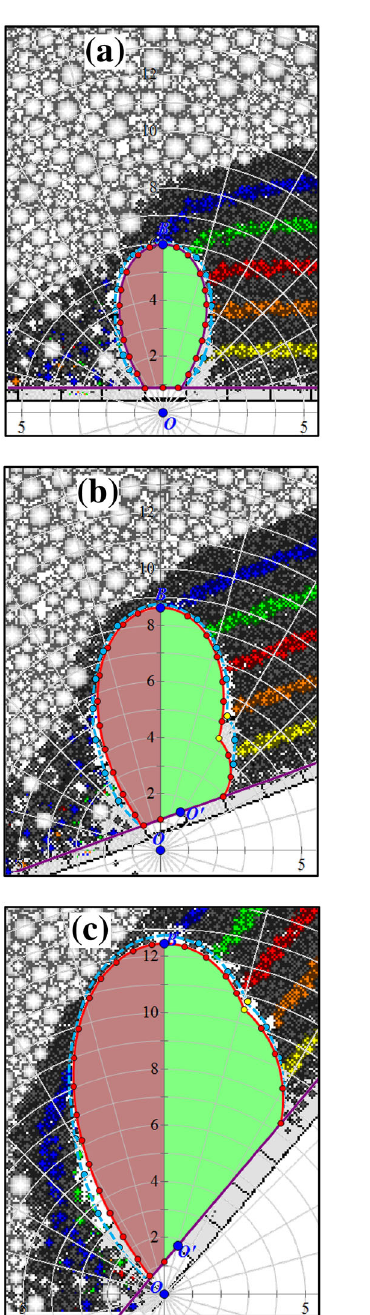
Fig. 14 Comparison of theoretical (red full curve) and numerically simulated (blue dashed curve) drawing body shapes in the normal drawing stage: a a = 0 (cid:3) ; b a = 20 (cid:3) ; c a = 50 (cid:3)